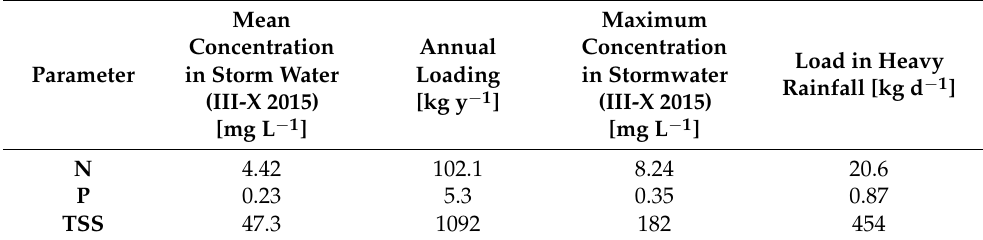
Table 6. Annual loads of nitrogen (N), phosphorus (P) and total suspended solids (TSS) entering lake waters with stormwater runoff.